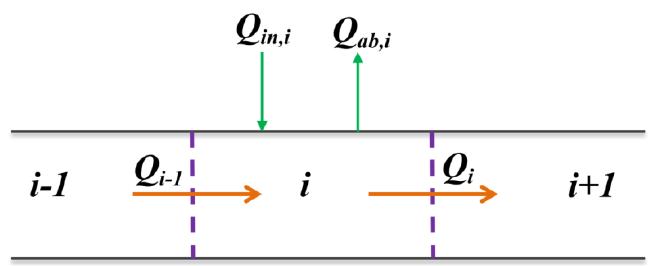
Figure 2. Flow balance for the first period of rivers.